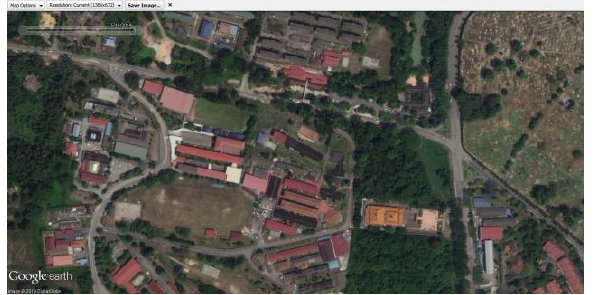
Figure 9a. Minimum resolution (1366 x 672)